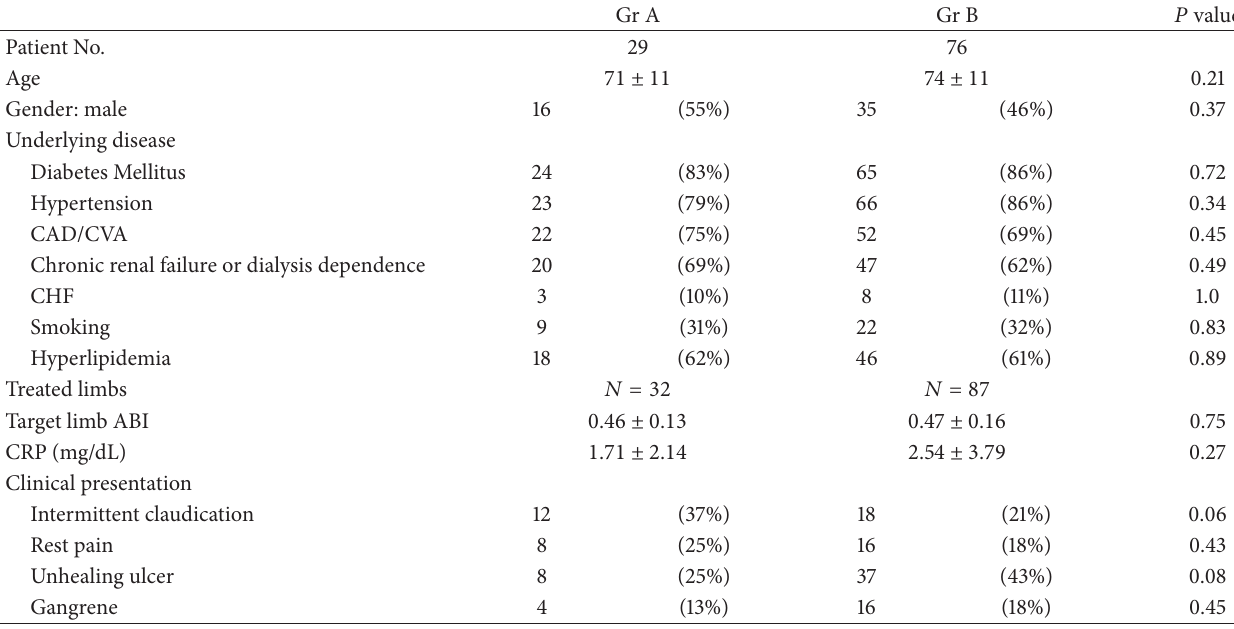
Table 1: Baseline demographics.